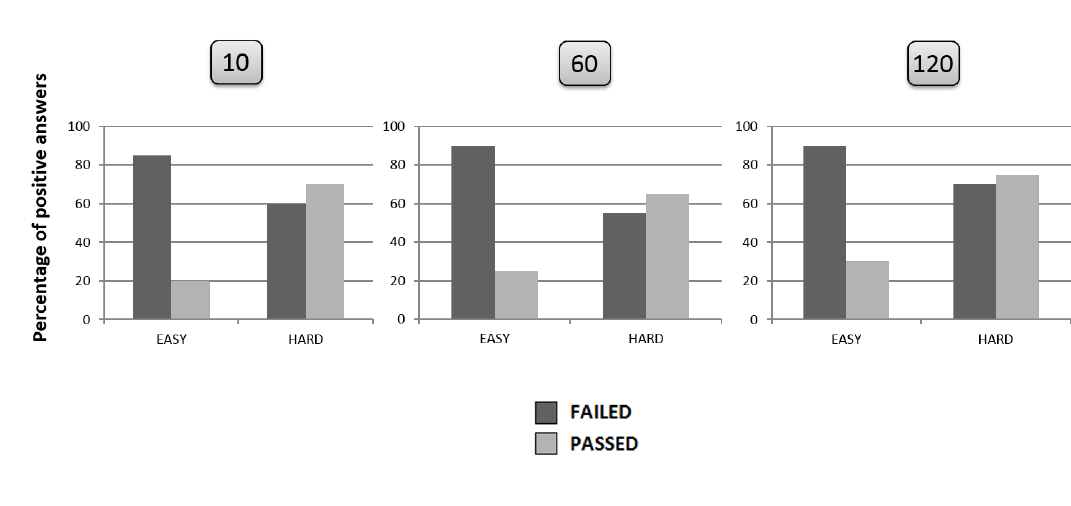
Figure 5 Percentages of positive answers by question, difficulty of the exam, and total number of